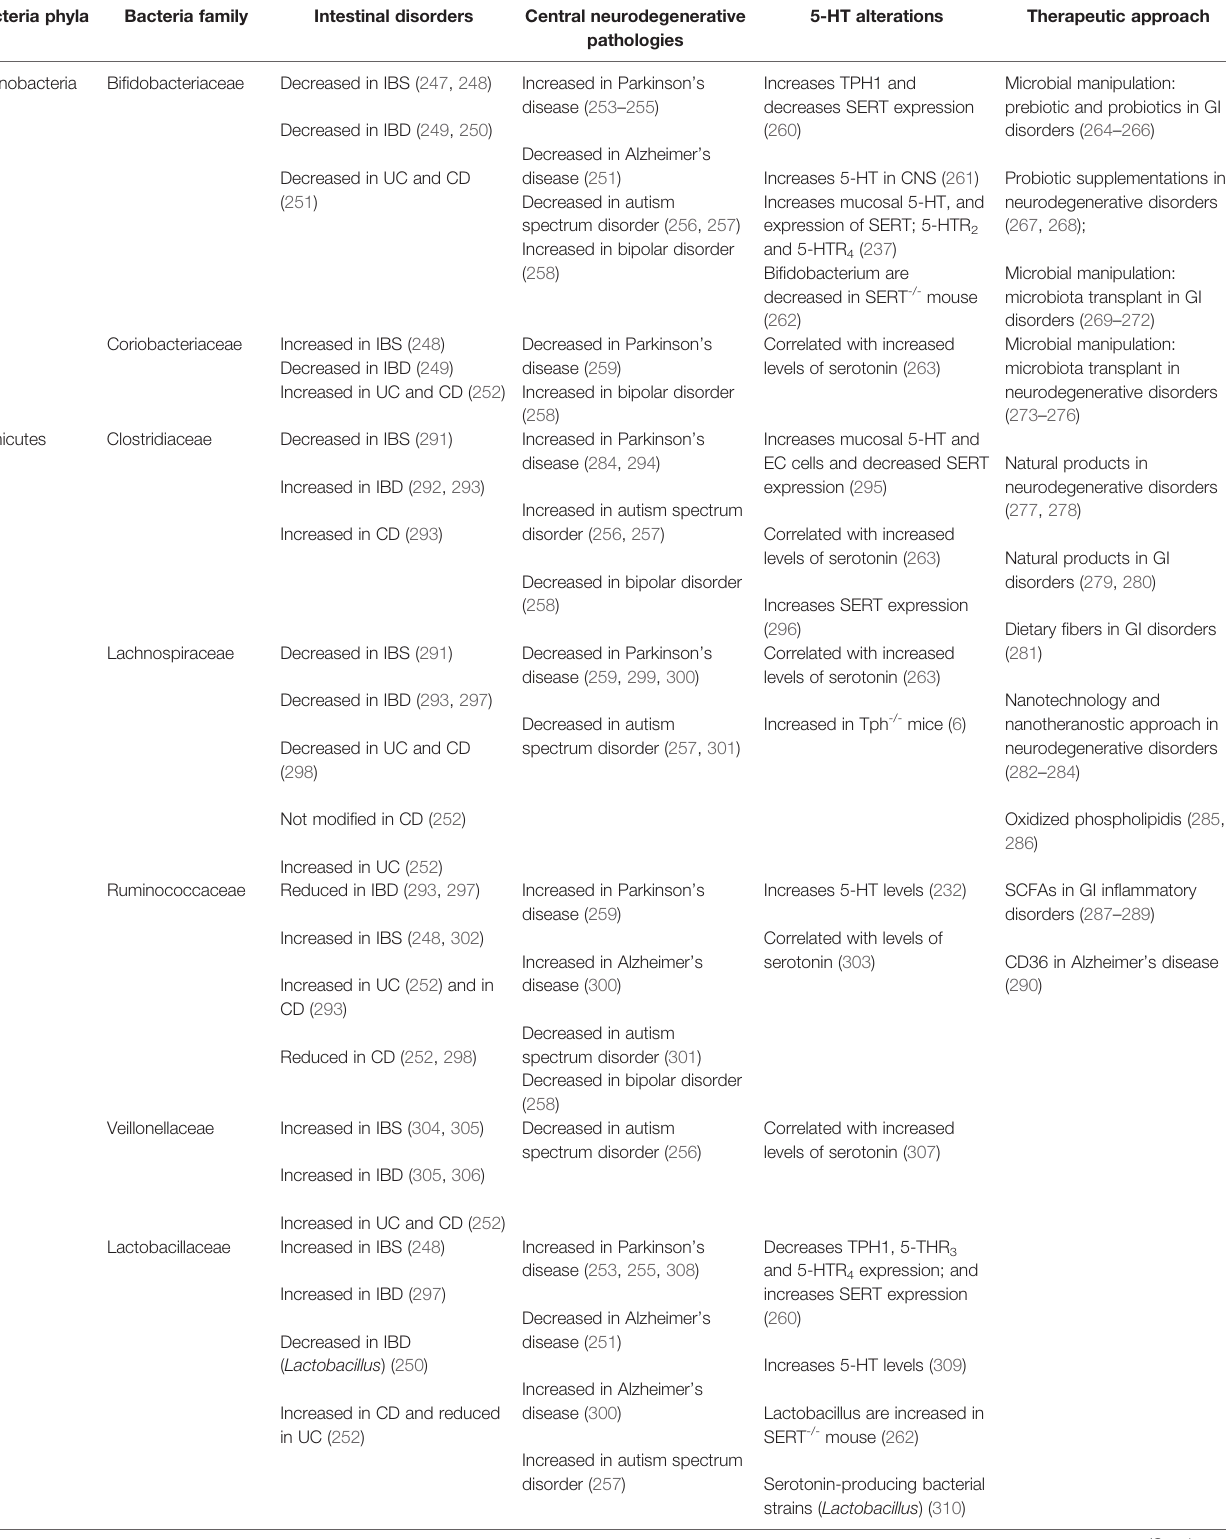
TABLE 4 | Gut microbiota in intestinal disorders (IBD and IBS) and neurodegenerative pathologies and their interaction with serotonergic system. Bacteria